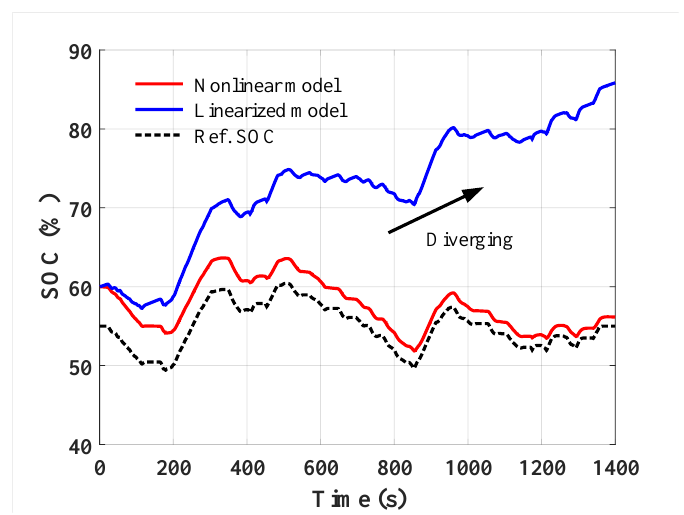
Figure 17. SOC estimation result with nonlinear model and linearized